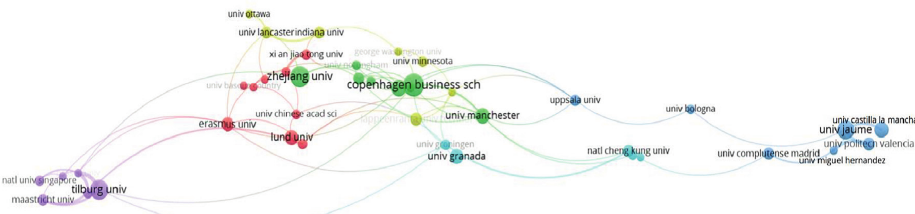
Figure 6: Institutional networks. Source: own elaboration with Web of Science and Scopus data (2018) processed with VOSviewer software.